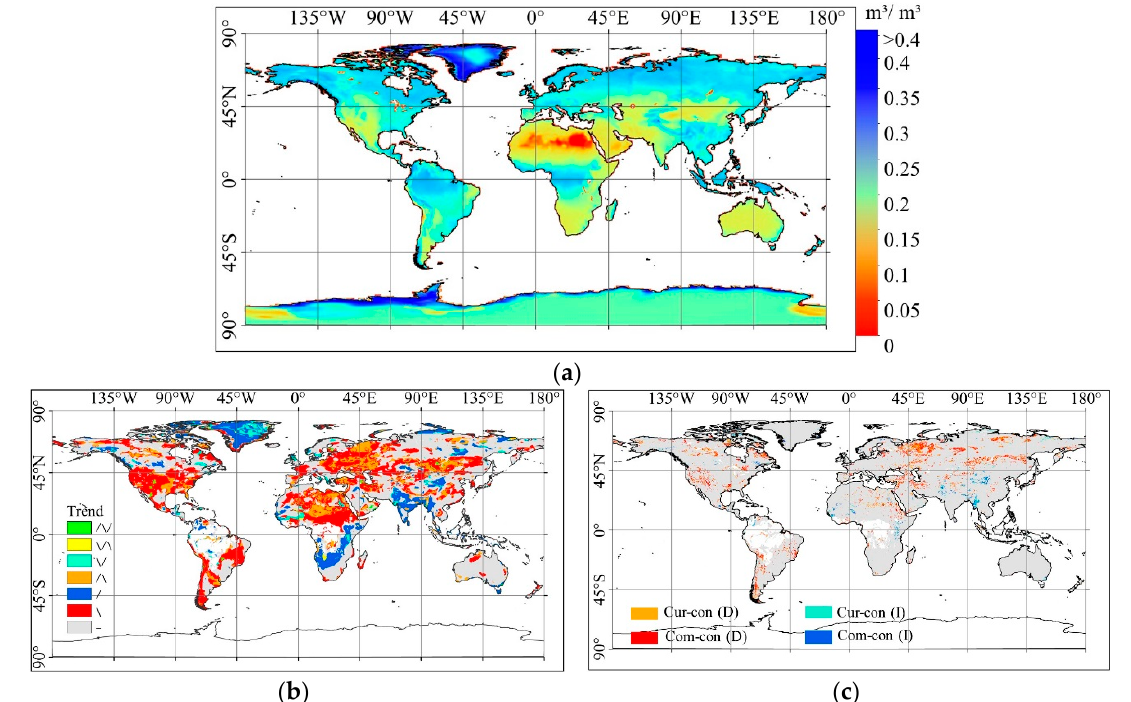
Figure 9. ( a ) Global pattern of mean SM from 1979–2016 based on the ERA-Interim (European Centre for Medium-Range Weather Forecasts (ECMWF) Interim Reanalysis) SM dataset. ( b ) Spatial distribution of annual trends ( b ) from the ERA-Interim SM, and ( c ) their consistency with European Space Agency (ESA) Climate Change Initiative (CCI) SM. “Cur-con”, “Com-con”, “D”, and “I” are abbreviations for “Currently consistent”, “Completely consistent”, “decreasing”, and “increasing”, respectively.